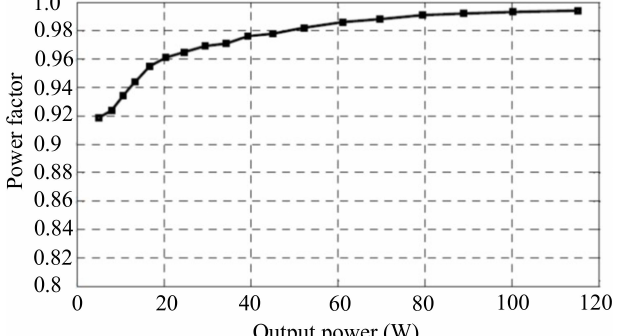
Figure 10. Power factor versus output power.